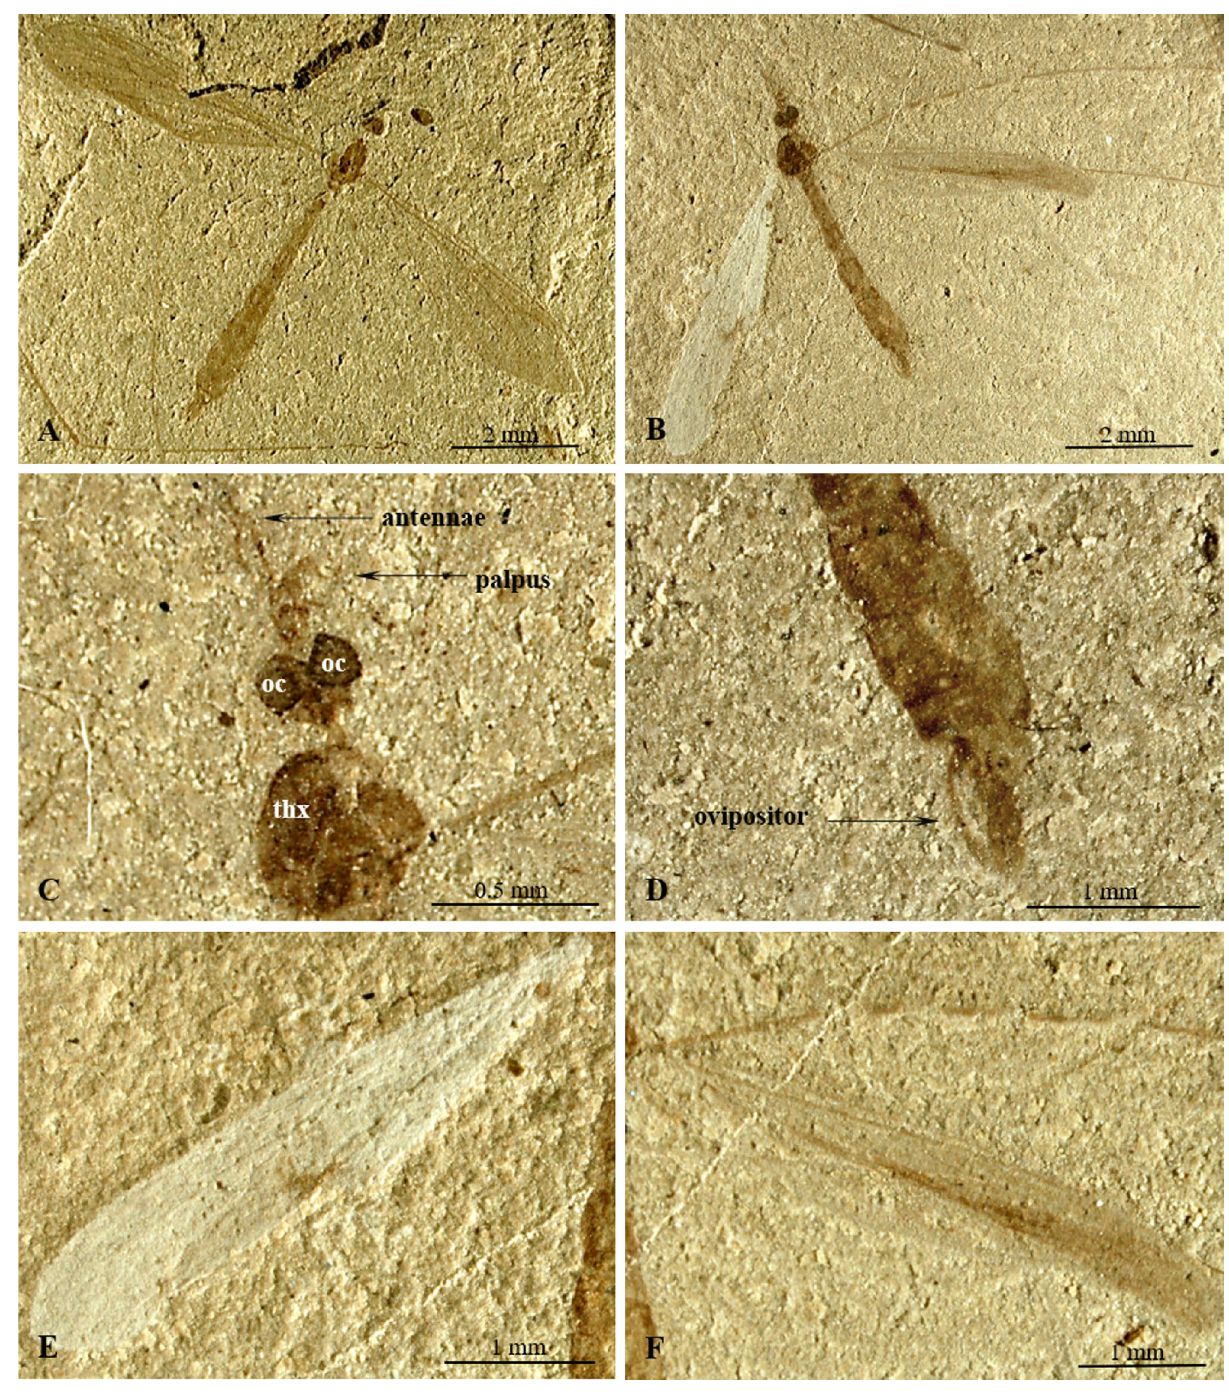
Figure 5. Cyttaromyia freiwaldi sp. nov.: ( A ) No. MNHN.F.A71342 (68, counterpart, female), (holotype), habitus, dorsal view; B.-F. No. MNHN.F.A71342 (70AB, female), (additional material): ( B ) habitus, dorsal view; ( C ) head, dorsal view; ( D ) terminal part of abdomen with ovipositor visible, dorsal view; ( E ) left wing; ( F ) right wing. oc, ocelli; thx,